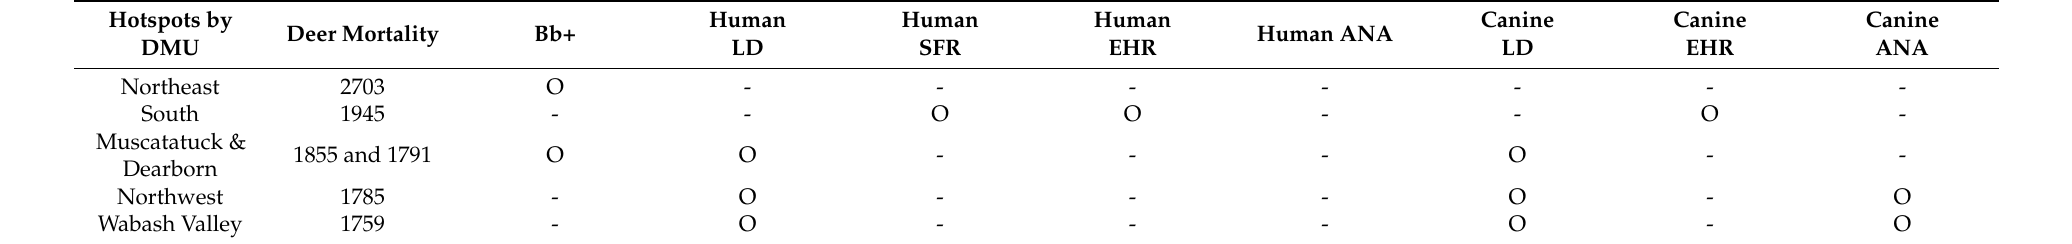
Table 7. Summary of Deer Mortality and TBD Rates Hotspots by DMU. TBD = TickBorne Disease; DMU = Deer Management Unit; Bb = Borrelia burgdorferi